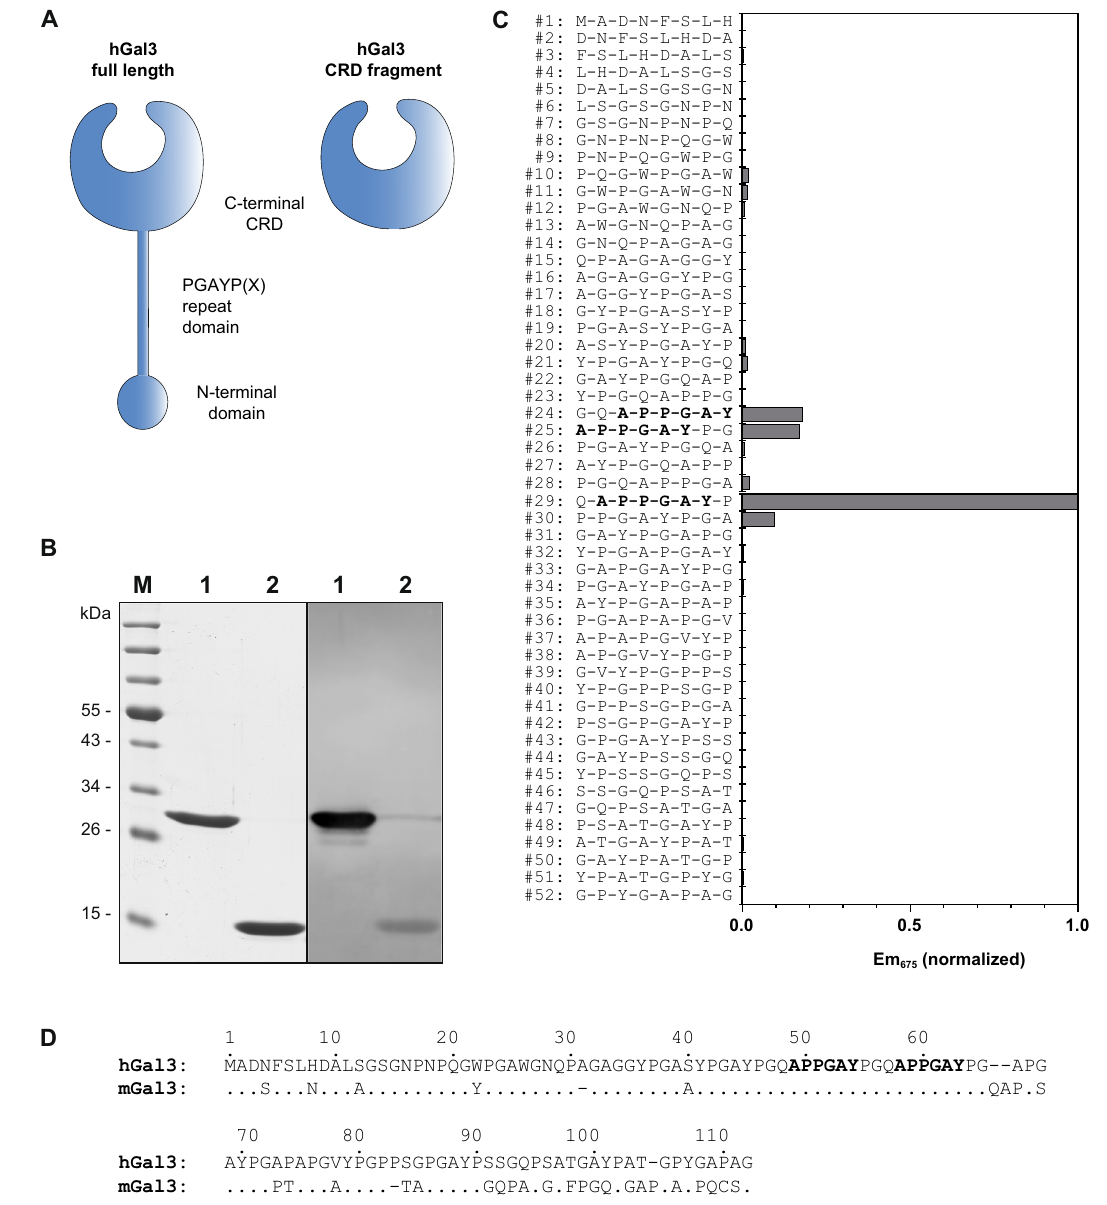
Figure 1. Elucidation of the hGal3 epitope recognized by the M3/38 Fab. ( A ) Schematic representation of the full-length hGal3 (27 kDa) and its truncated CRD (residues 113–252; 14 kDa) which were investigated here. ( B ) Western-blot analysis of the full length recombinant hGal3 and its CRD with the chimeric αhGal3-Fab- PAS200-Cy5.5. Lanes: M, molecular size standard; 1, full length hGal3; 2, hGal3 CRD. Left: coomassie-stained SDS-PAGE. Right: western-blot probed with the fluorescent chimeric αhGal3-Fab-PAS200-Cy5.5. ( C ) Linear epitope scan of the ND of hGal3 using the SPOT technique and the chimeric αhGal3-Fab-PAS200-Cy5.5 for direct detection by fluorescence at 675 nm (normalized to 1). The 8mer peptides cover the sequence of the ND of hGal3 as shown in ( D ) with a two-residue offset. ( D ) Amino acid sequence alignment between the NDs of human and murine Gal3 (sequence numbers are indicated for the human protein). The epitope of the αhGal3- Fab seen in ( C ) is highlighted in bold. Graphics were prepared using Quant version 12.2 (https:// total lab. com) and Origin(Pro) version 2017 (https:// www. origi nlab.